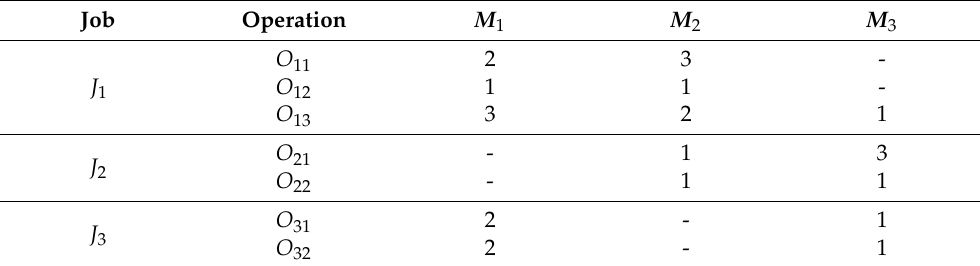
Table 1. Machine processing schedule of the flexible job shop scheduling (FJSP) instance. ‘-’ means that the process cannot be processed by this